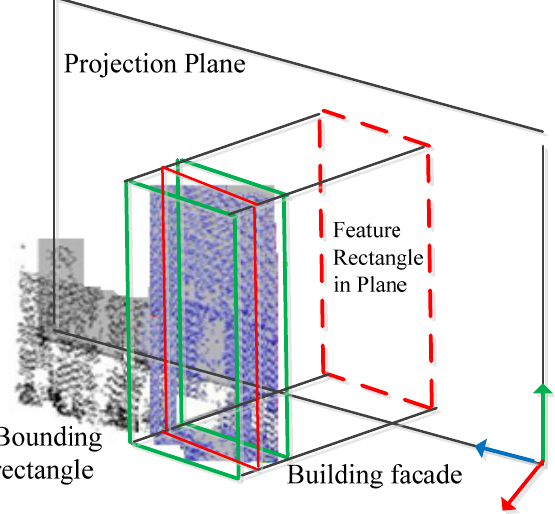
Figure 13. Building façade from plane detection.